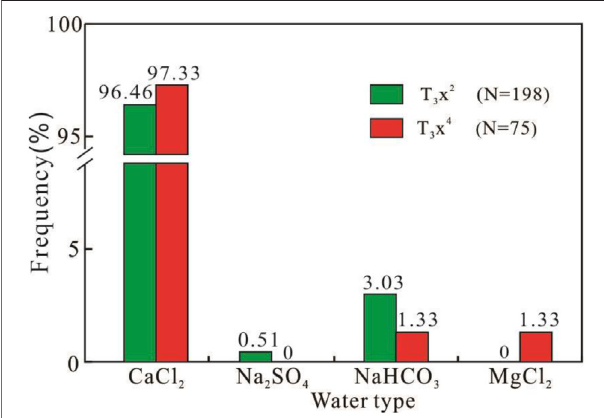
FIGURE 3 | Distribution characteristics of the formation water types of the Xujiahe Formation in the middle section of the western Sichuan